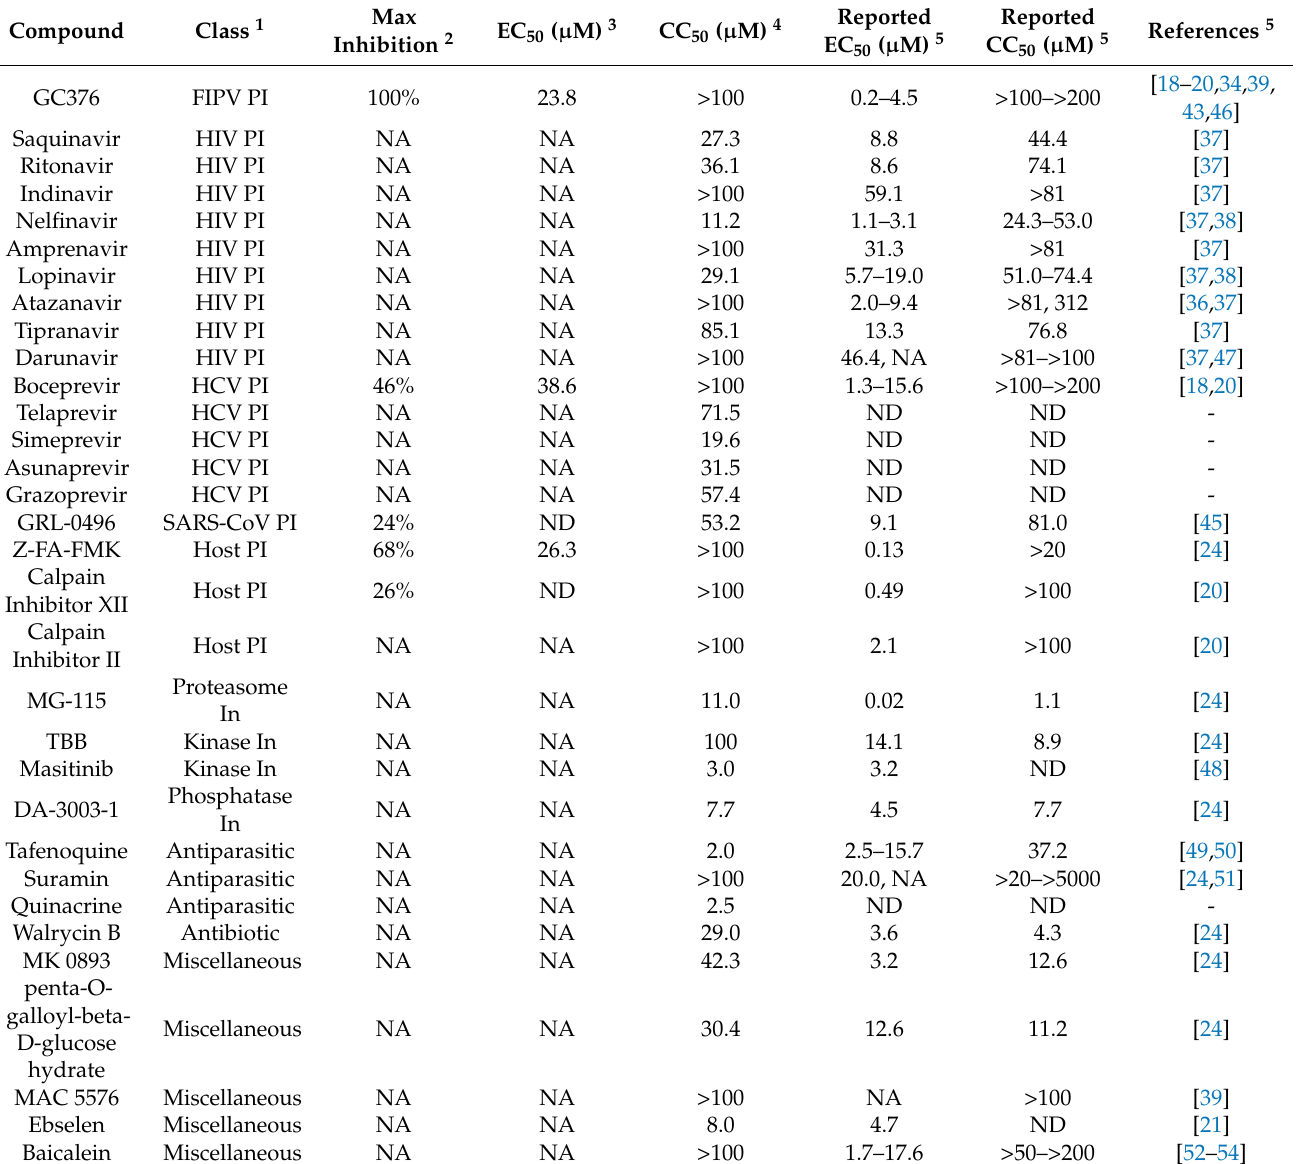
1 Compound class: FIPV PI, feline infectious peritonitis virus protease inhibitor, HIV PI, human immunodeficiency virus protease inhibitor; HCV PI, hepatitis C virus protease inhibitor, SARS PI, severe acute respiratory syndrome coronavirus protease inhibitor; Host PI, host protease inhibitor; In, inhibitor. 2 Maximum inhibition of SARS-CoV-2 3CL pro in cell-based luciferase complementation assay relative to 100 µ M GC376, which was set to 100%; NA, no activity. 3 Half maximal effective concentration (EC 50 ) values, as determined by the SARS-CoV-2 3CL pro luciferase complementation assay. ND, not determined; EC 50 values could not be calculated for two compounds due to weak activity (calpain inhibitor XII) or overlapping activity and cytotoxicity (GRL-0496); NA, no activity. 4 50% cytotoxic concentration (CC 50 ) values, as determined by the CellTiter-Glo 2.0 assay. 5 Previously reported EC 50 (and corresponding CC 50 ) values for inhibition of SARS-CoV-2 replication in cell culture. Note that, in some cases, EC 50 values may be affected by compound toxicity. ND, not determined; NA, no